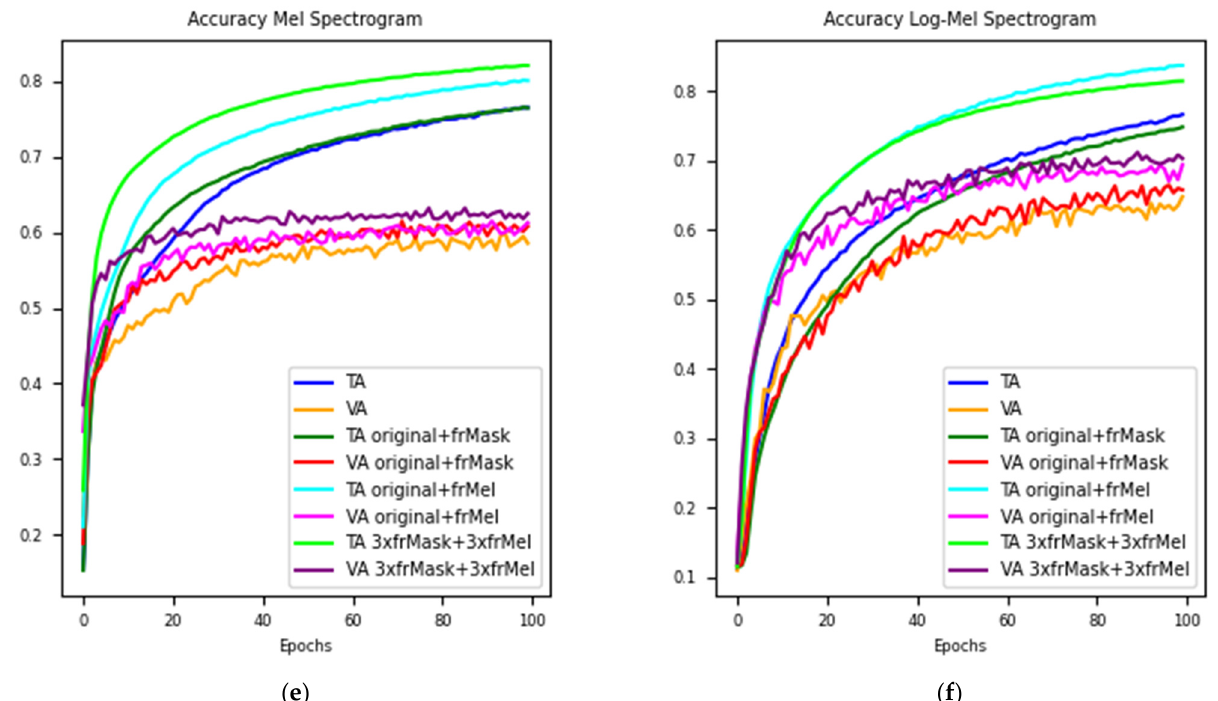
Figure 2. Accuracy scores and accuracy and loss graphs for experiments: ( a ) Accuracy scores for Mel spectrogram features; ( b ) Accuracy scores for log Mel spectrogram features. ( c ) Loss curve for Mel Spectrogram features; ( d ) Loss curve for Mel Spectrogram features; ( e ) Accuracy curve for Mel spectrogram features; ( f ) Accuracy curve for log Mel spectrogram features.